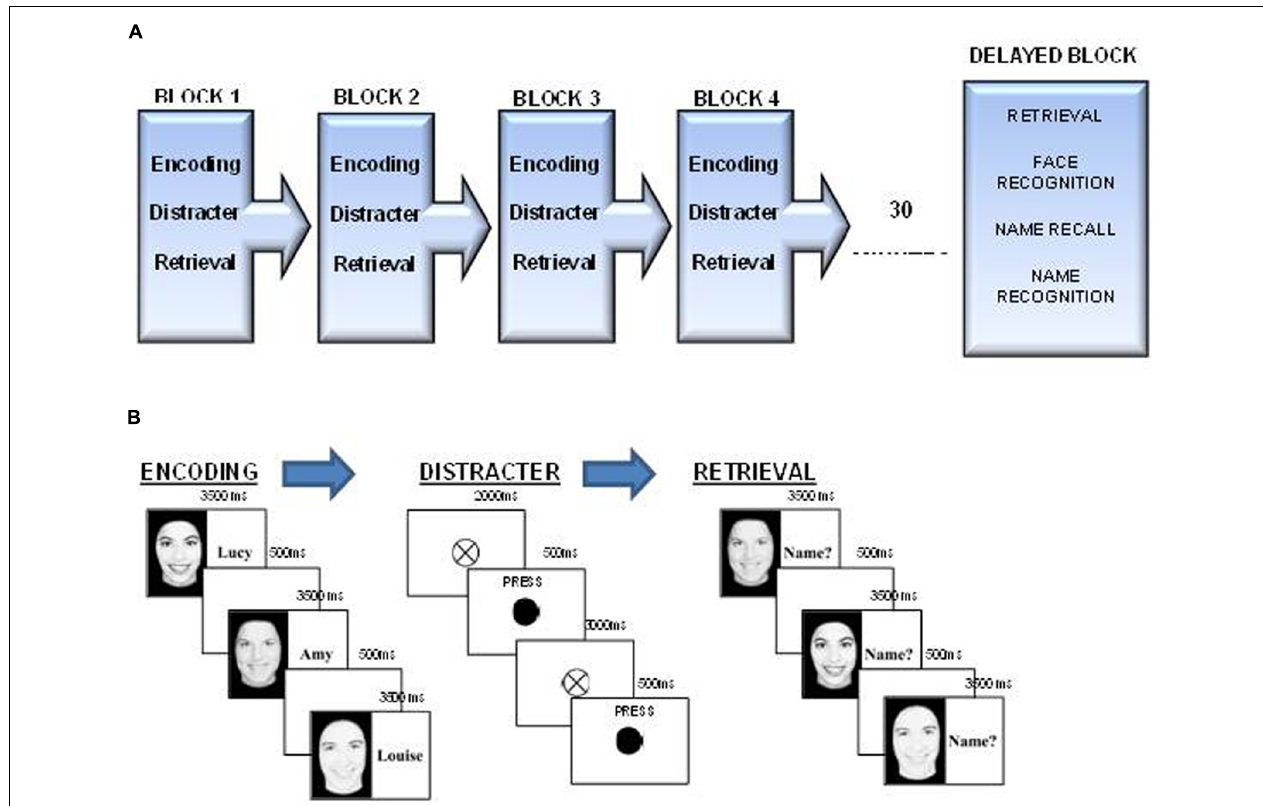
FIGURE 1 | (A) FNP running order. The Face-Name task comprises four blocks of encoding, distraction, and immediate retrieval followed by a block of delayed retrieval, which also involved name recall and face and name recognition components. (B) FNP; Encoding, distracter, and retrieval components. Participants first encoded the six faces and